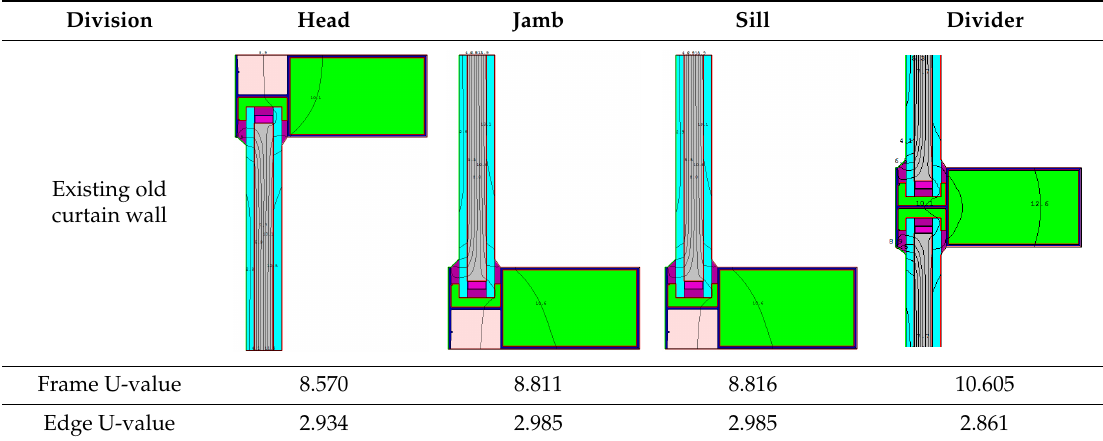
Table 8. Analysis results for the thermal properties of the frame parts of the existing old curtain wall. Division